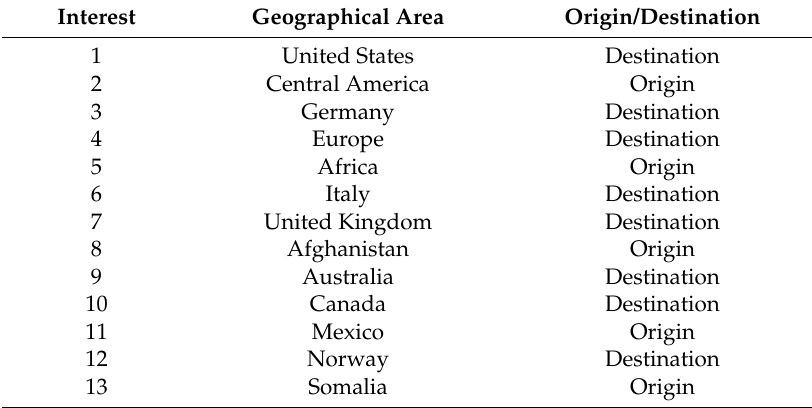
Table 3. Geographical areas of origin or destination reflected in the